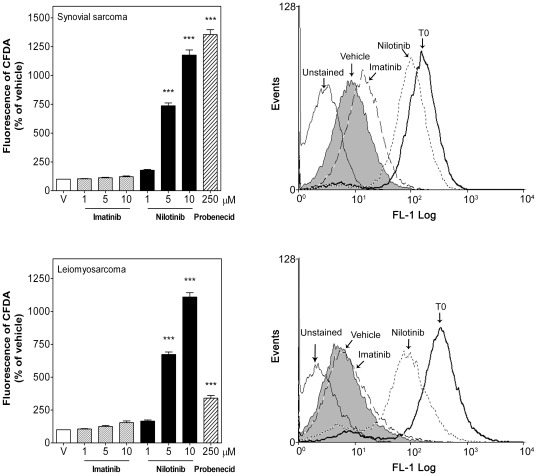
Nilotinib inhibited MRP-1 activity in human STS cells.Intracellular 5(6)-CFDA fluorescence was estimated by flow cytometry in synovial sarcoma SW982 and leiomyosarcoma SK-UT-1 cells after 2 h treatment with vehicle (V), imatinib (1–10 µM), nilotinib (1–10 µM) or probenecid (250 µM). Left, Median of intracellular CFDA fluorescence in the absence or presence of TK inhibitors normalized to vehicle-treated cells (taken as 100%). Each column represents mean ± SEM of three independent experiments. Right, Representative flow cytometry analysis of the intracellular CFDA fluorescence in the absence (vehicle) or presence of imatinib (10 µM) or nilotinib (10 µM) detected with excitation at 488 nm and emission at 530 nm. T0 was the intracellular CFDA fluorescence measured at t = 0. ***
P<0.001 versus vehicle-treated cells.